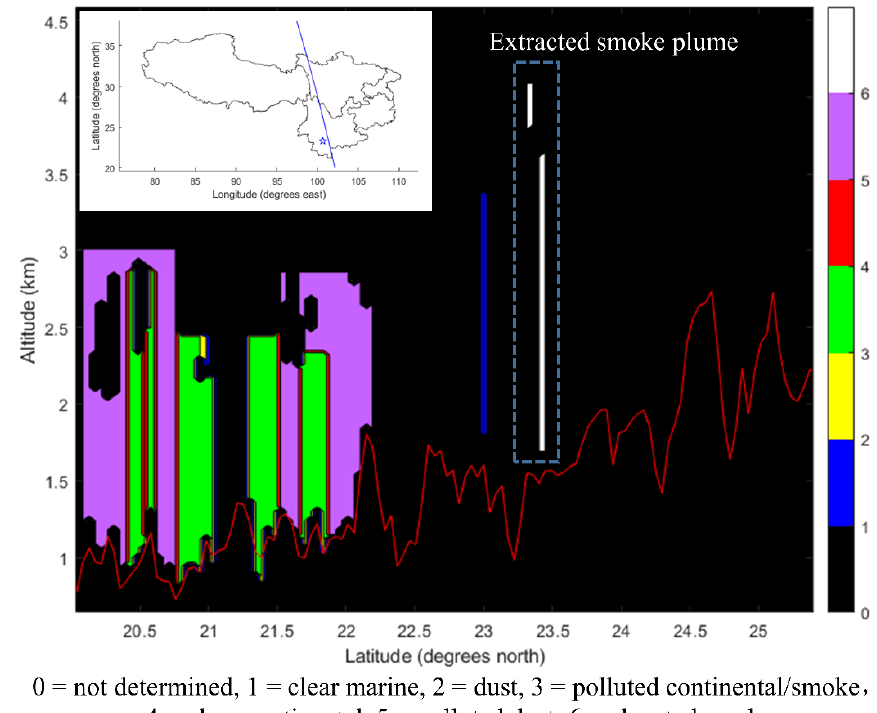
Figure 2. CALIPSO swath and aerosol vertical feature mask of the fire over Southwest China on 29 April 2015. The blue line crossing from south to north is the CALIOP track. The blue star is the location of the fire. The blue dashed box marks the smoke of the fire case captured by CALIPSO. The red line represents the surface elevation below smoke.